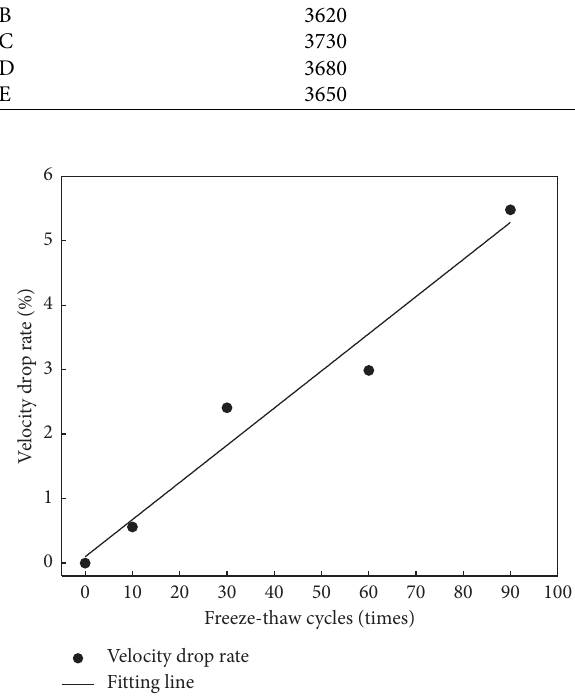
Figure 3: Relationship between number of freeze-thaw cycles and measured change in wave velocity of the samples.